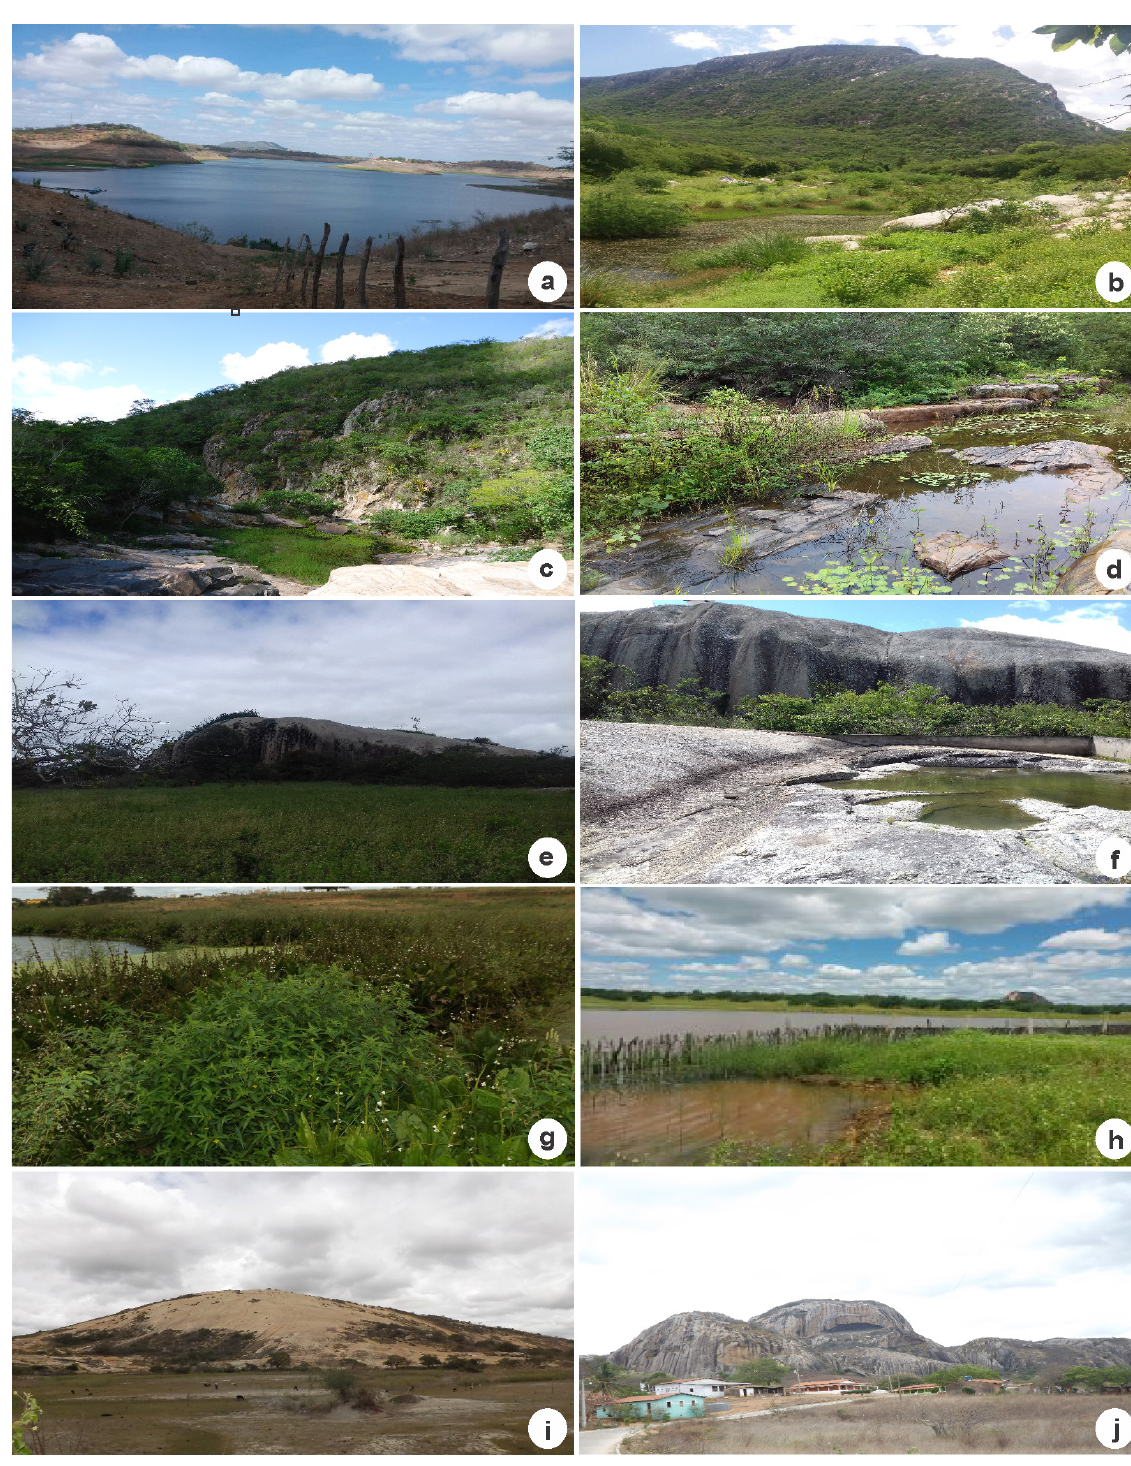
Fig. 2. Environments where species of Ludwigia L. were detected in the studied area, Paraíba